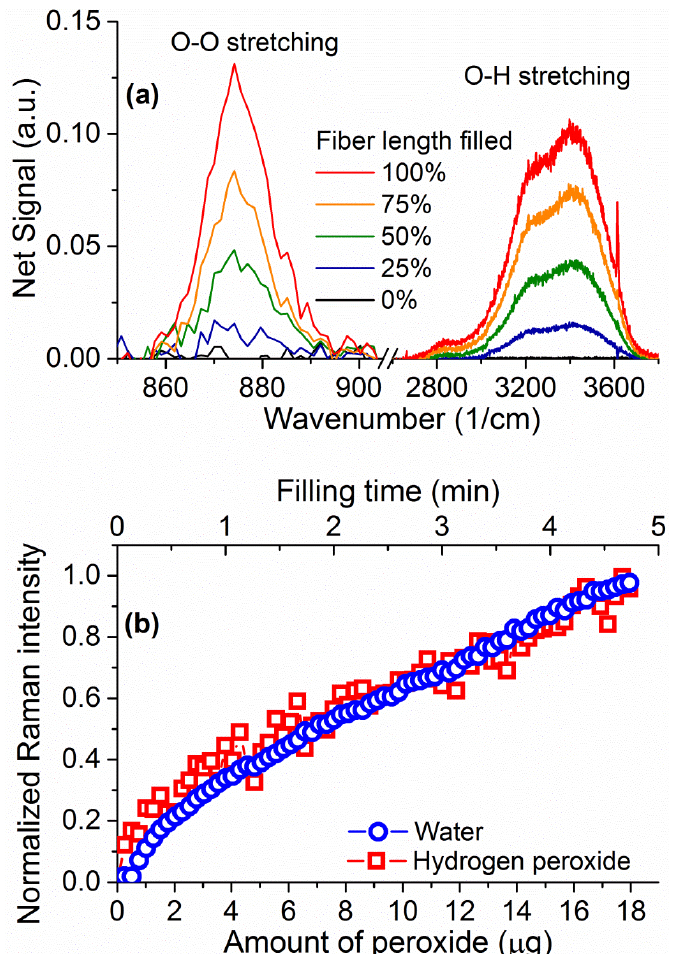
Figure 7. ( a ) Signal evolution for the hydrogen peroxide (876 cm −1 ) and water (3,400 cm −1 ) Raman signals, after subtraction of the glass background signal as a function of the filled length percentage of the fiber; ( b ) Integrated intensity for the hydrogen peroxide (squares) and water (circles) Raman spectra as a function of the amount of hydrogen peroxide inside a suspended core fiber. Both graphs are shown for a 30% w.t. concentration of hydrogen peroxide in